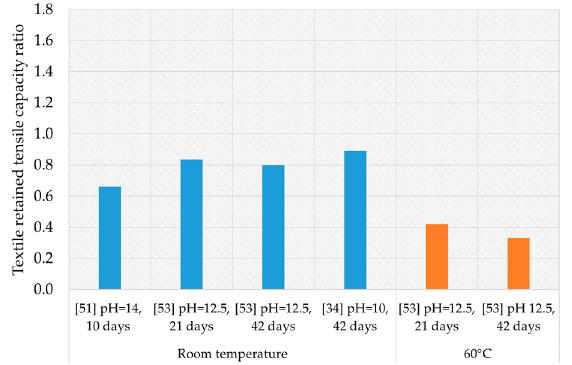
Figure 7. Retained tensile capacity ratio of AR-glass exposed to alkaline environments (blue bin = room temperature and orange bin = temperature equal to 60 °C).